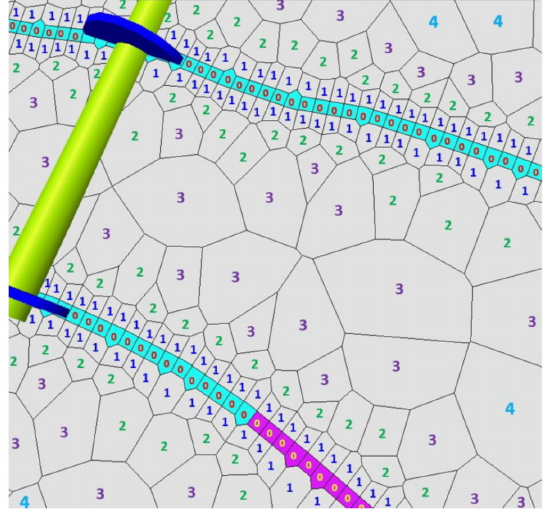
Figure 11. Concept diagram of unstructured gridding for stimulated reservoir volume (SRV) calcula- tion [33].